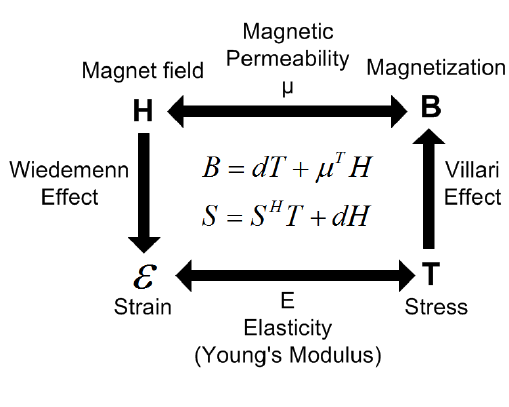
Figure 5. Magnetomechanical coupling in